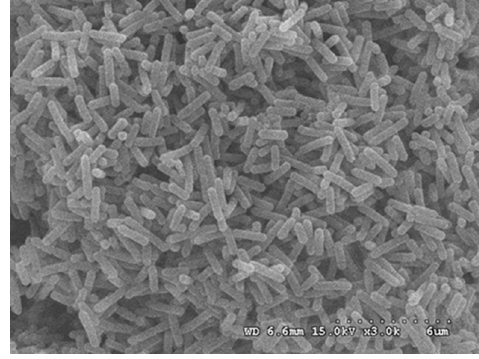
Figure 3. The SEM image of LB 5-3 on LB agar medium after 20 h of culture.